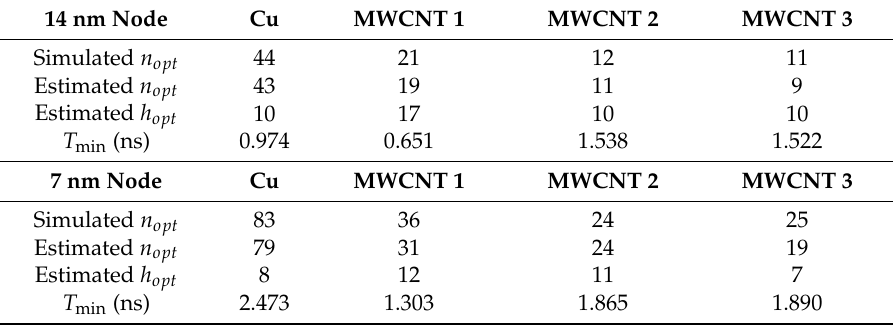
Table 4. Comparison of the simulated and estimated optimal number of repeaters, repeater size, and